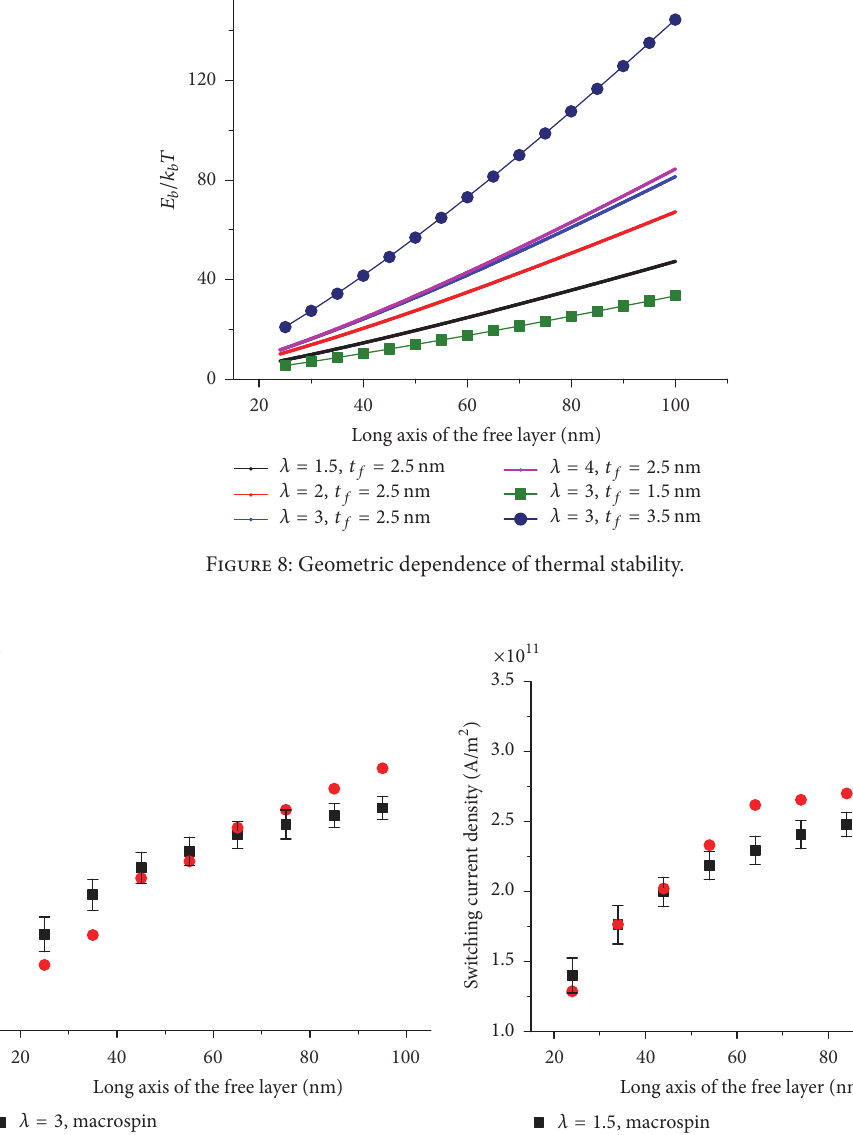
the geometry dependent thermal stability and the spin torque efficiency in room temperature (300 K) are